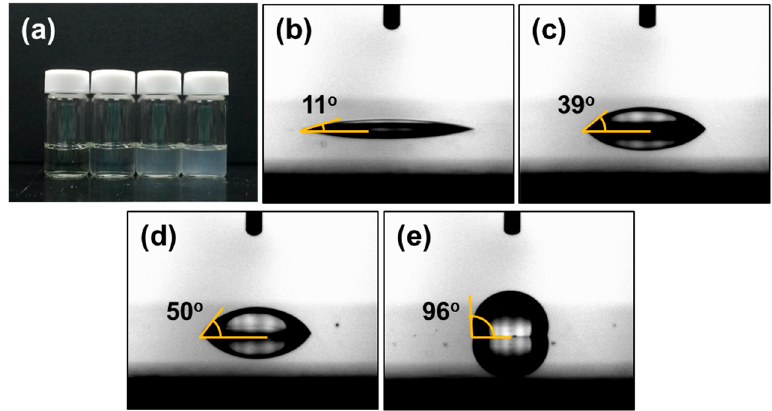
Figure 2. ( a ) Optical images of P(SS- co -VTMS) solutions and water contact angle images of PSS and P(SS- co -VTMS) films; ( b ) VTMS 0 mol%; ( c ) VTMS 5 mol%; ( d ) VTMS 10 mol%; ( e ) VTMS 15 mol%.